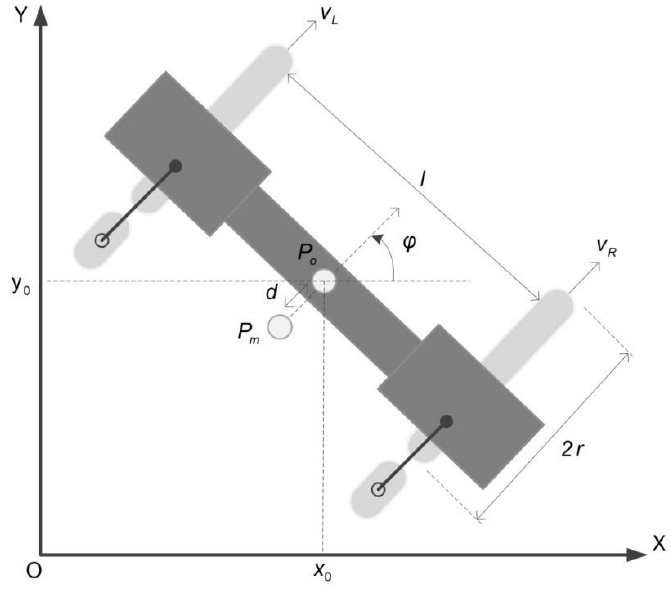
Figure 3. The representation of the position and orientation of the two-wheeled robot in the Carte- sian coordinate system. Dark gray, light gray, and black color represent the mechanism body, wheels, and support stands, respectively.